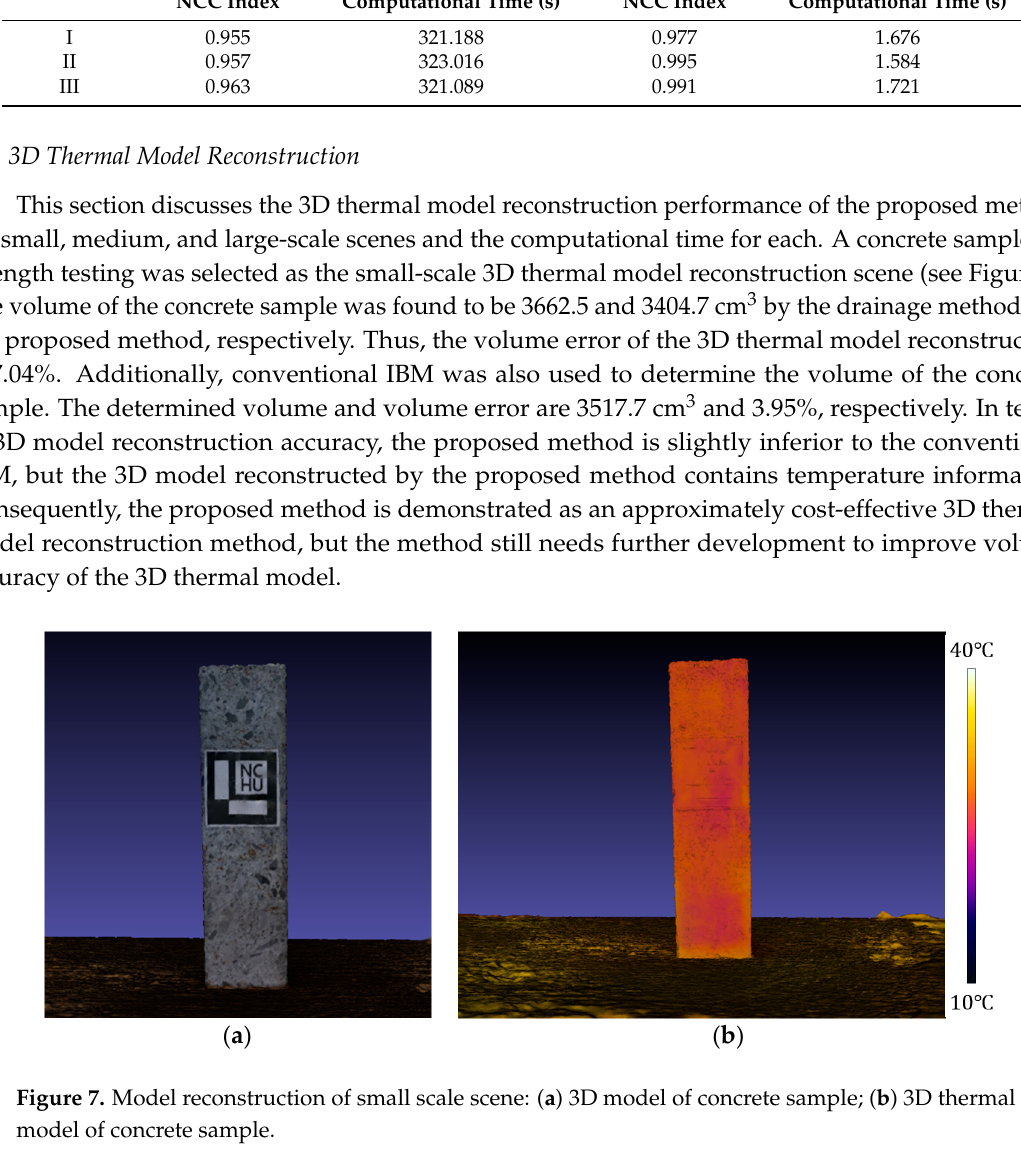
( b ) ( c ) Figure 8. Model reconstruction of medial scale scene: ( a ) visible image of classroom scene; ( b ) 3D model of classroom scene; ( c ) 3D thermal model of classroom scene.